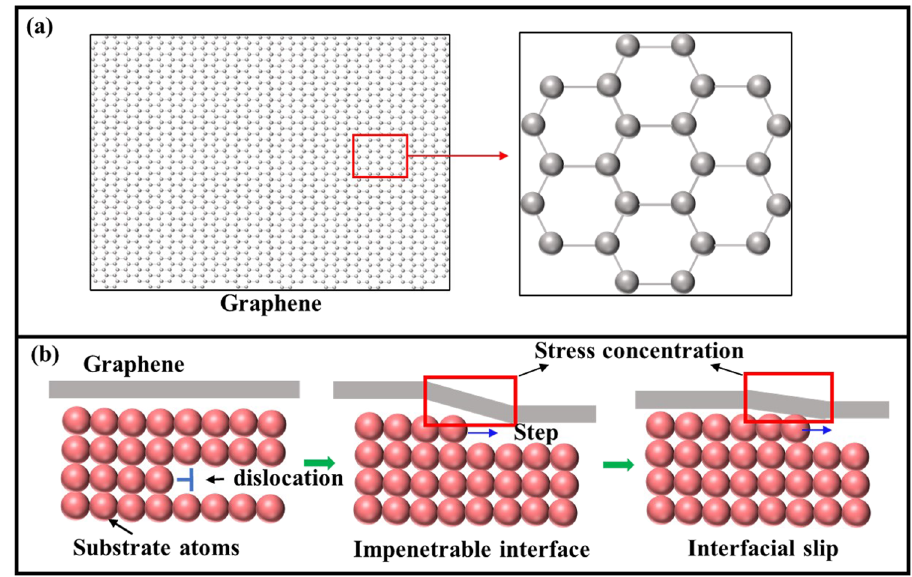
Figure 15: ( a ) The honeycomb lattice arrangement of graphene ( b ) the interaction between dislocation and